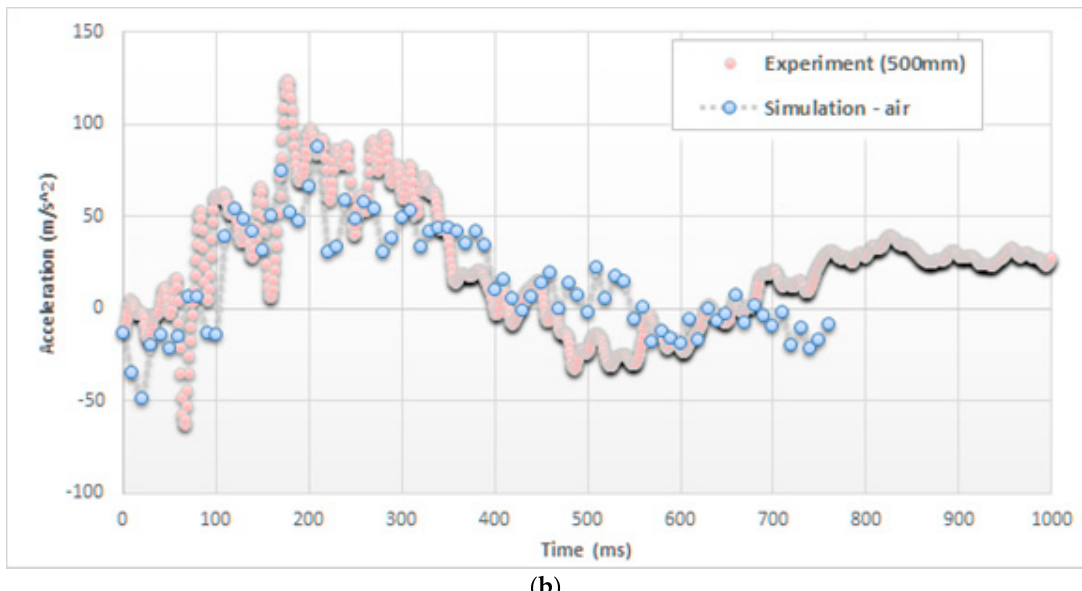
Figure 6. Comparison of acceleration on the top of the cylinder (drop height of 500 mm), ( a ) without and ( b ) with considering the air effect.